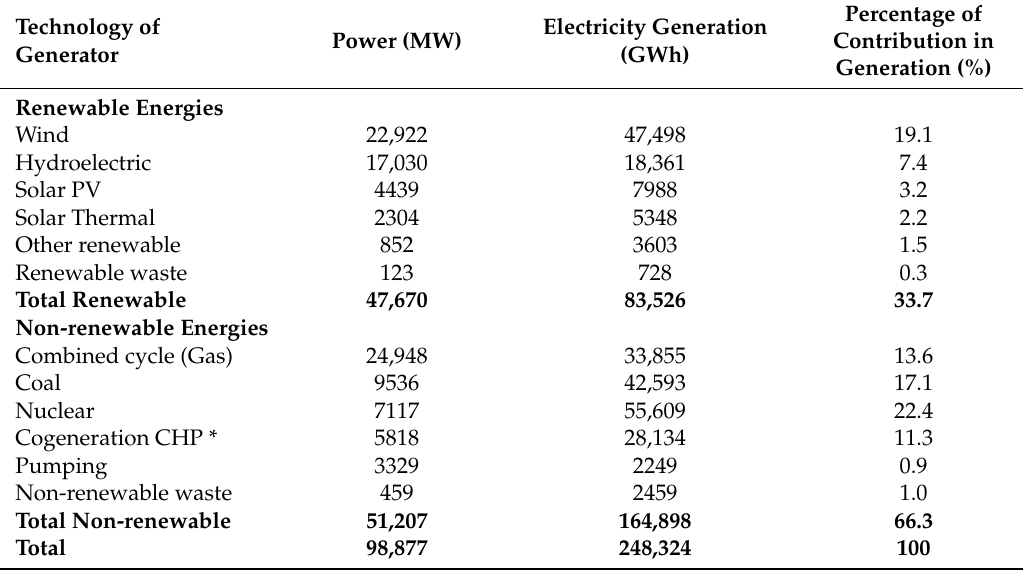
Table 3. Electric power sources in Spain at the Iberian Peninsula